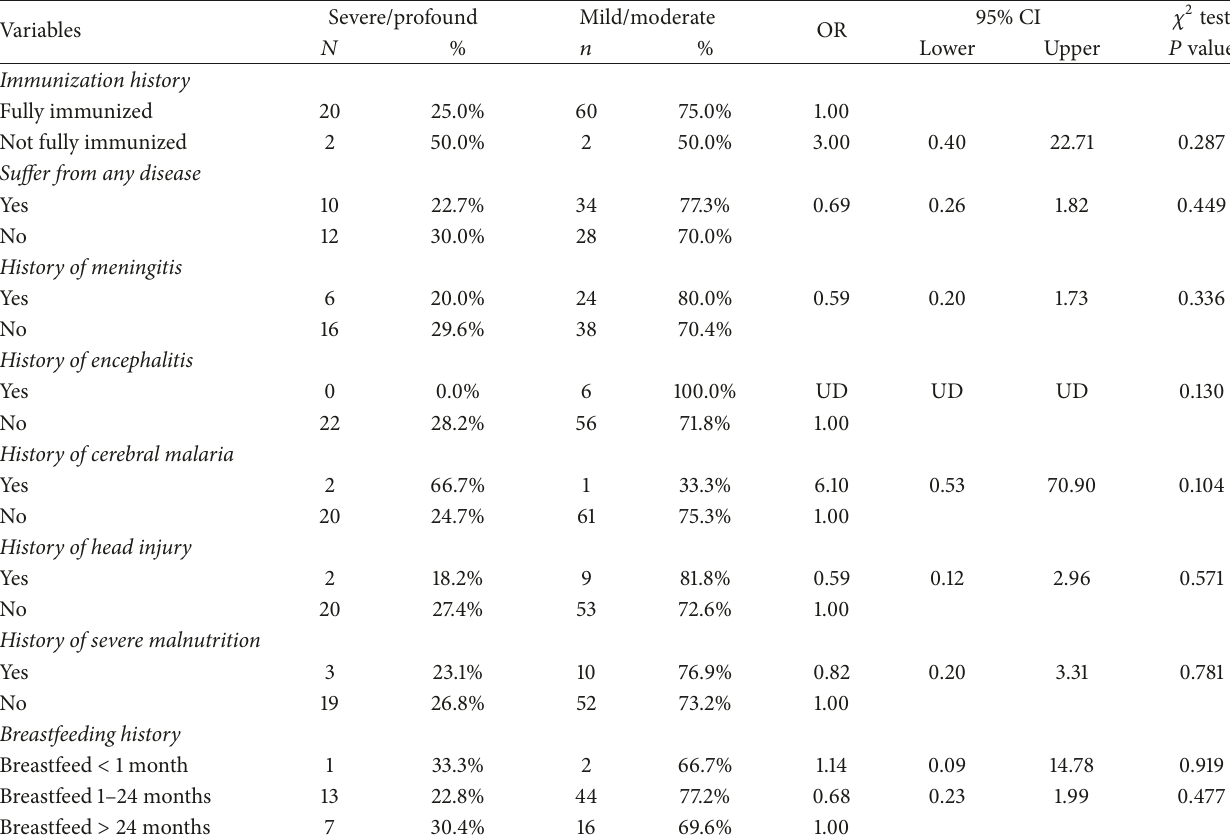
Table 8: Association of infant and childhood medical history with severity of intellectual